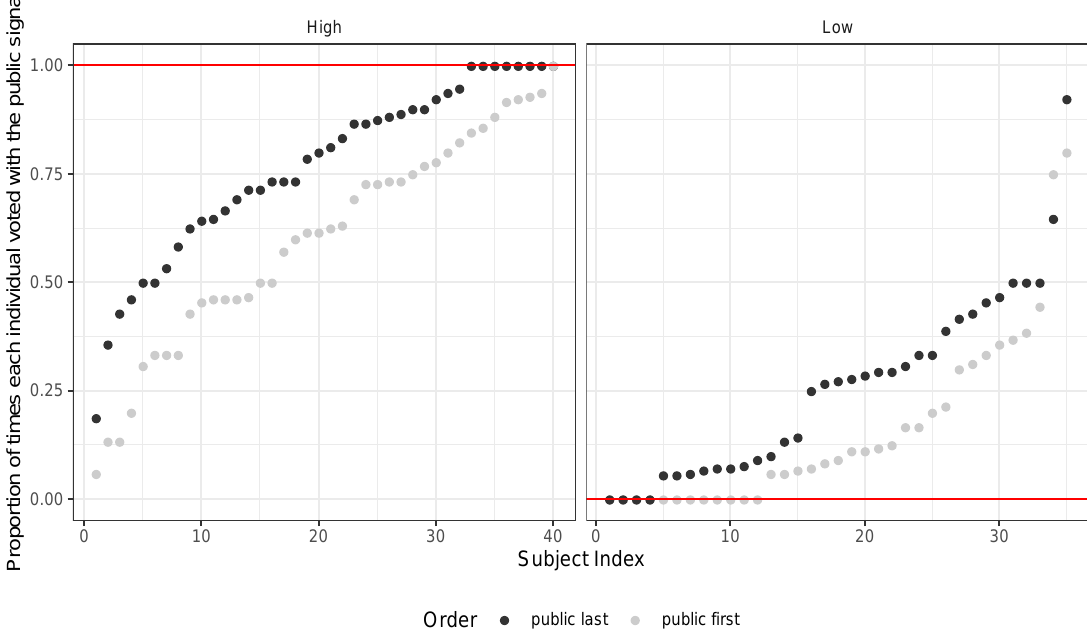
Figure 8. Recency effect (individual sessions) . Each dot represents the proportion of rounds an individual votes with the public signal. Dark dots correspond to when the public signal is more recent, light dots when the private is more recent. The left image plots values for sessions where Q > q , the right one Q < q . Horizontal lines represent the symmetric responsive equilibrium predictions for µ